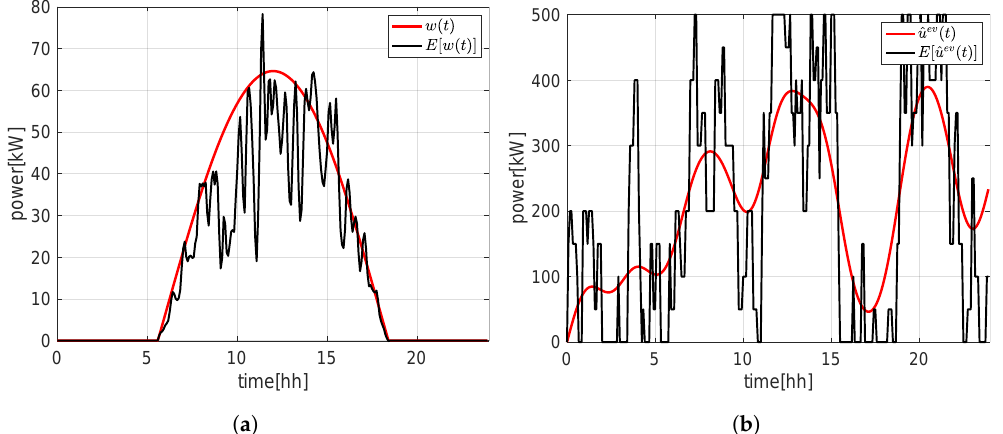
Figure 3. The curve w ( t ) and ˆ u ev ( t ) chosen for the simulations. The black line represents the expected values of E [ w ( t )] and E [ ˆ u ev ( t )] in ( a ) and ( b ), respectively; the red line represents a realization of the actual curve w ( t ) and ˆ u ev ( t ) in ( a ) and ( b ), respectively. ( a ) Curve w ( t ) chosen for the simulations; ( b ) The curve ˆ u ev ( t ) chosen for the